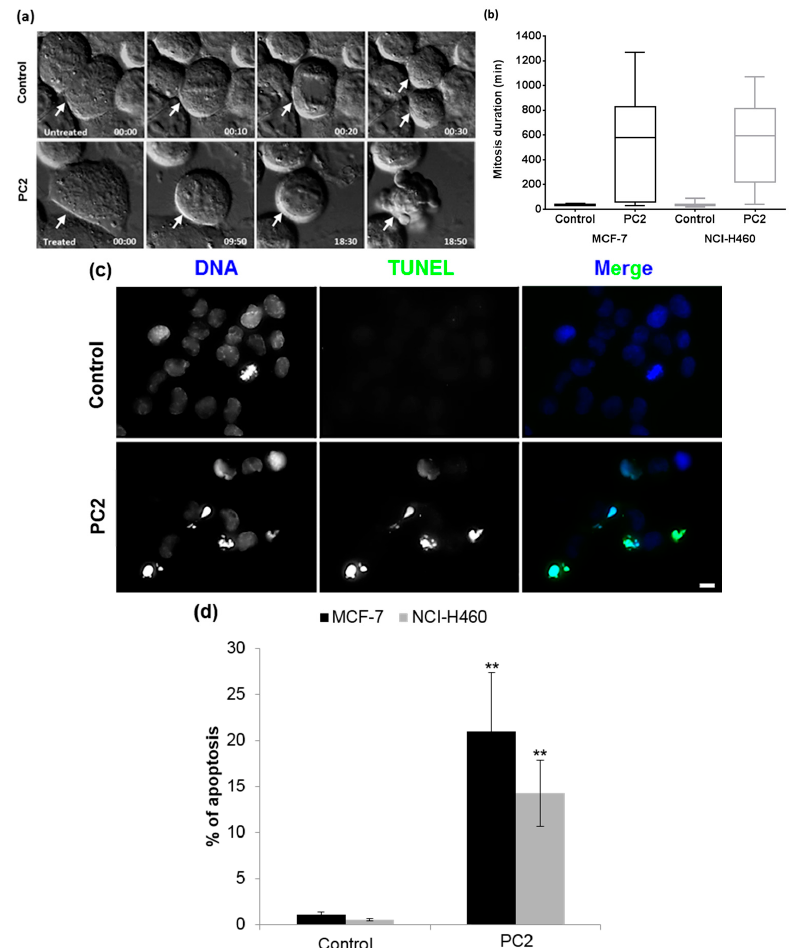
Figure 5. Treatment with PC2 induces mitotic catastrophe and cell death of MCF-7 and NCI-H460 cells. ( a ) Live-cell imaging to determine cell fate in response to compound. Cells were treated with the compound and tracked for up to 48 h. Examples of time-lapse sequences showing a control MCF-7 cell (white arrow, top panel) undergoing normal mitosis giving rise to two daughters, and a treated MCF-7 cell (white arrow, bottom panel) delayed in mitosis and ending in cell blebbing. Numbers indicate times in hours. Similar results were obtained for NCI-H460 cells (not shown). Movies are available as Supplementary Materials (Videos S1 to S4); ( b ) Box plot showing mitosis duration in minutes, in each condition for the two cell lines; ( c ) TUNEL staining showing accumulation of apoptotic cells (green) in MCF-7 cultures incubated with the compound for 48 h. DNA was counterstained with DAPI (blue). Similar results were obtained for NCI-H460 cells (not shown). Scale bar = 5 μ m; ( d ) Apoptotic index in control cells and upon 48 h compound treatment, expressed as a percentage of total cells. (**) represents p < 0.01.